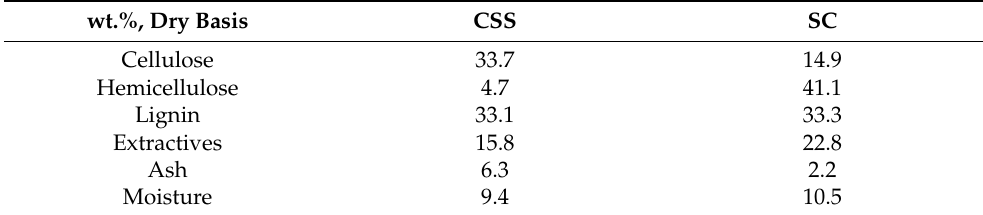
Table 1. Lignocellulosic components and extractive fractions, ash, and moisture in CSS and SC. wt.%, Dry